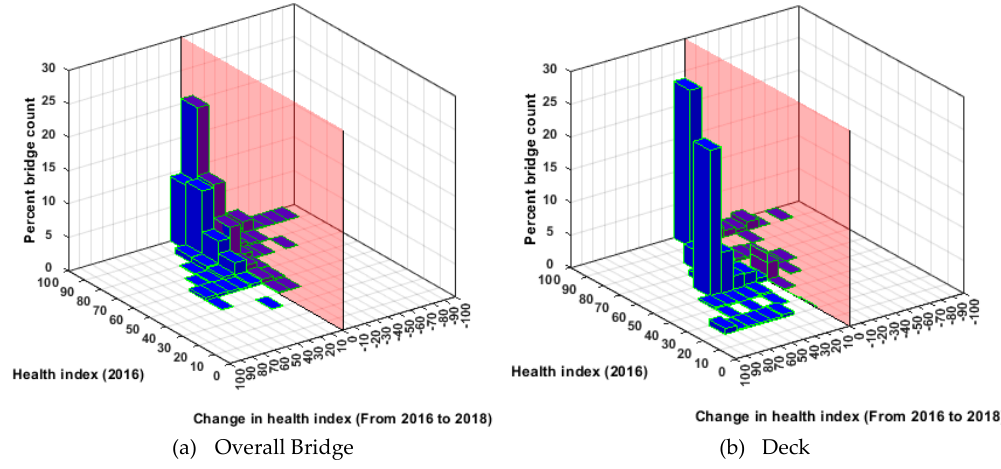
Figure 7. National Highway System (NHS) vs. non-NHS bridge in Virginia. Infrastructures 2020 , 5 , x FOR PEER